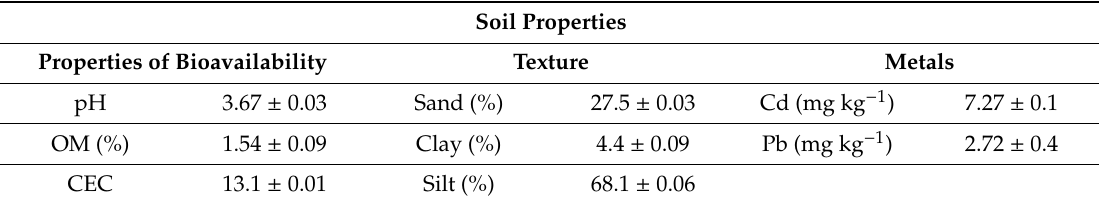
Table 4. Physical and chemical characteristics of the soil from “El Alacr á n” gold